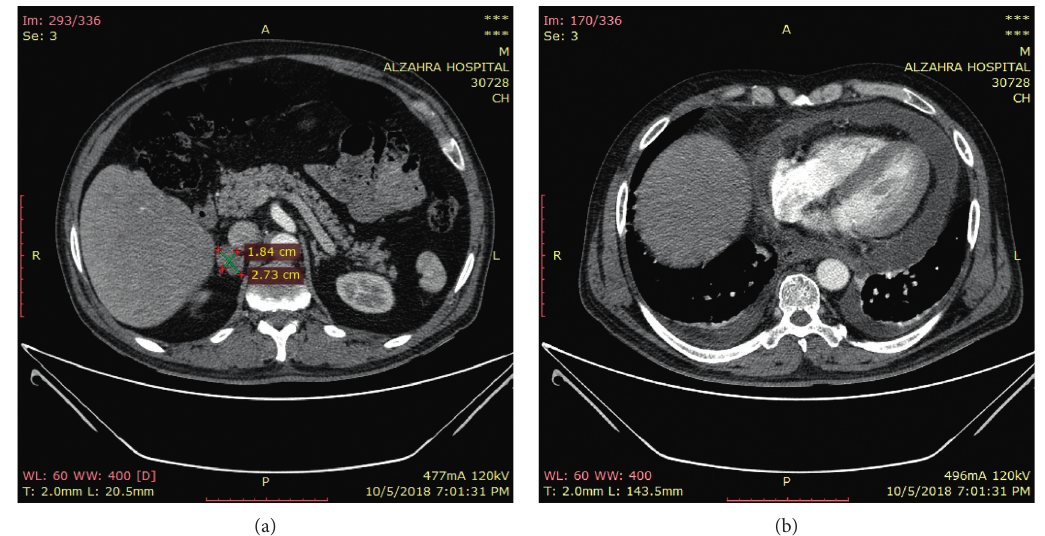
Figure 1: Chest and abdominal CT scan of the patient shows heterogeneous right adrenal mass (a) and pericardial and bilateral pleural effusion